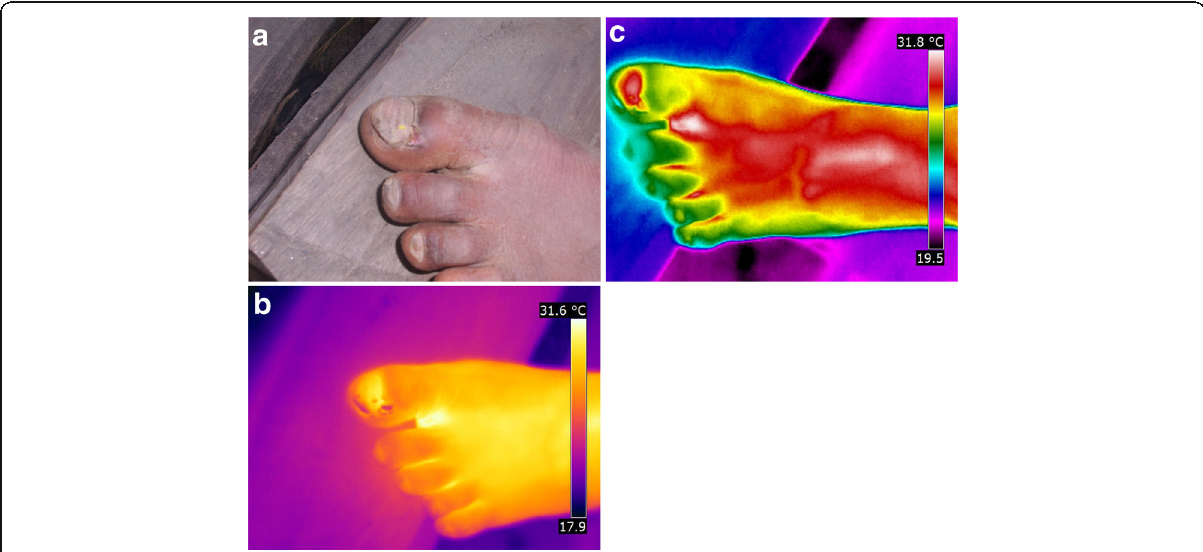
Fig. 1 ( a ) left foot with two manipulated lesions at the medial nail fold of the first toe and at the base of the first and second toe. ( b ) left foot, hyperthermic area s at the medial nail fold of the first toe and the base of the first and second toe (iron transformation). ( c ) left foot, hyperthermic area s at the medial nail fold of the first toe and the base of the first and second toe (rainbow